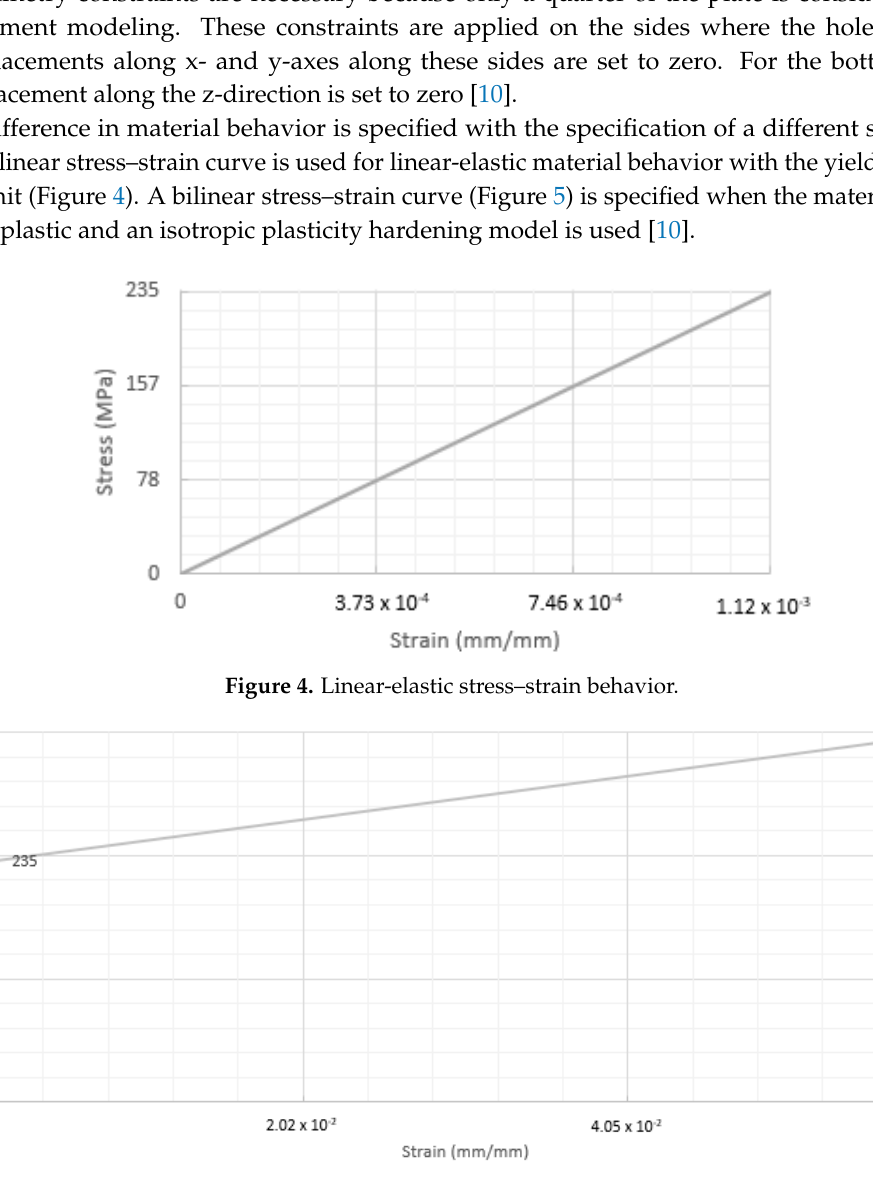
Figure 5. Elastic-plastic stress–strain behavior.